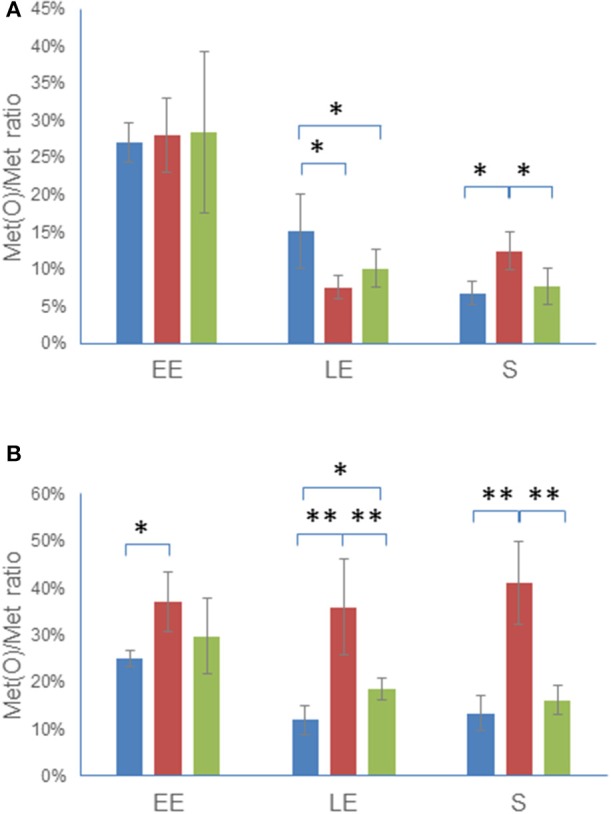
Dynamics of Met(O) content in ΔmsrAB mutant cells and complemented ΔmsrAB/pHT304msrAB cells. WT (blue), ΔmsrAB (red), and ΔmsrAB/pHT304msrAB (green) were grown in MOD medium as described in Figure 2. The cells were harvested at EE, LE and S growth phases. The Met(O) content of the intracellular proteome (A) and exoproteome (B) was calculated as the percentage of the number of Met(O) vs. the total number of Met residues. Data are the means of triplicate measures obtained from three independent cultures at the EE, LE, and S growth phases. Significant differences between two strains are indicated with one (p < 0.05) or two (p < 0.01) asterisks.